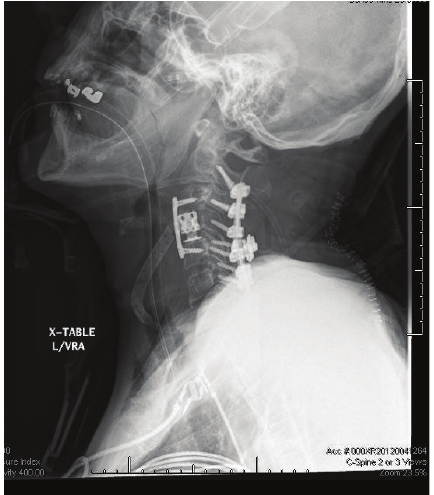
Figure 3: Postoperative cervical spine X rays demonstrating cervical corpectomy with placement of cage and posterior lateral mass instrumentation.